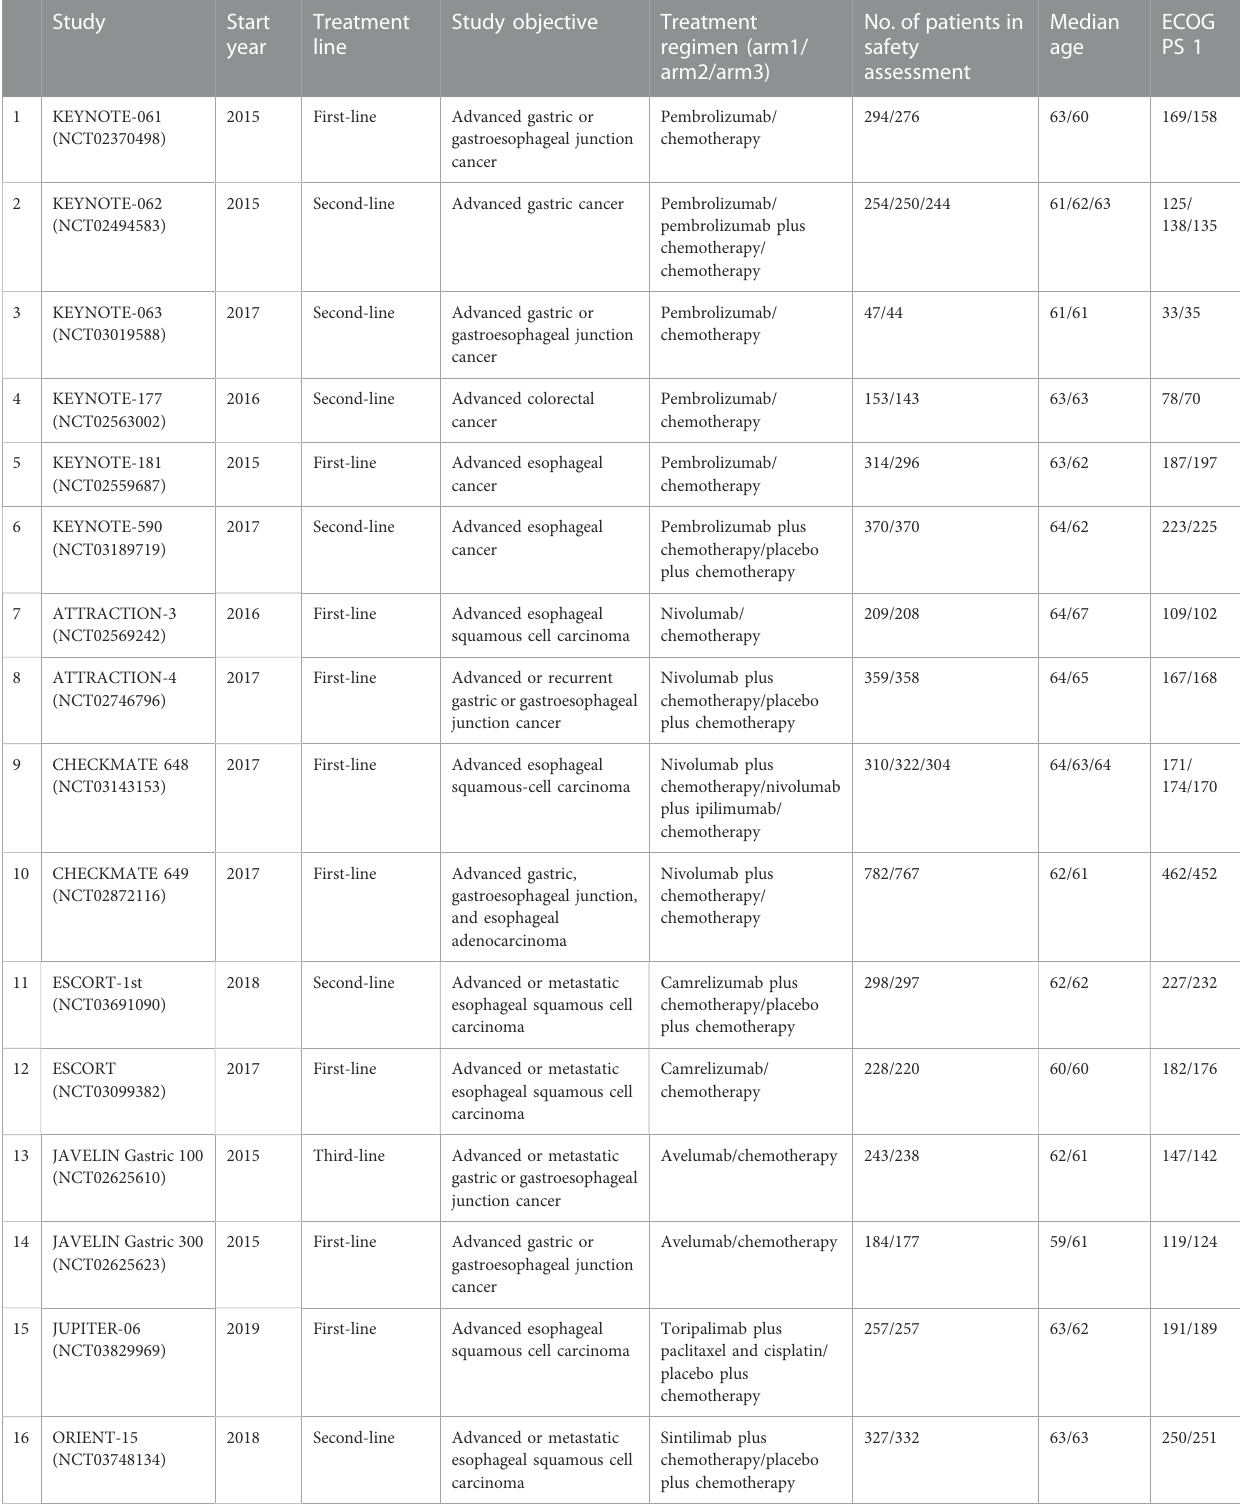
TABLE 1 Studies evaluating safety of immune checkpoint inhibitors with or without